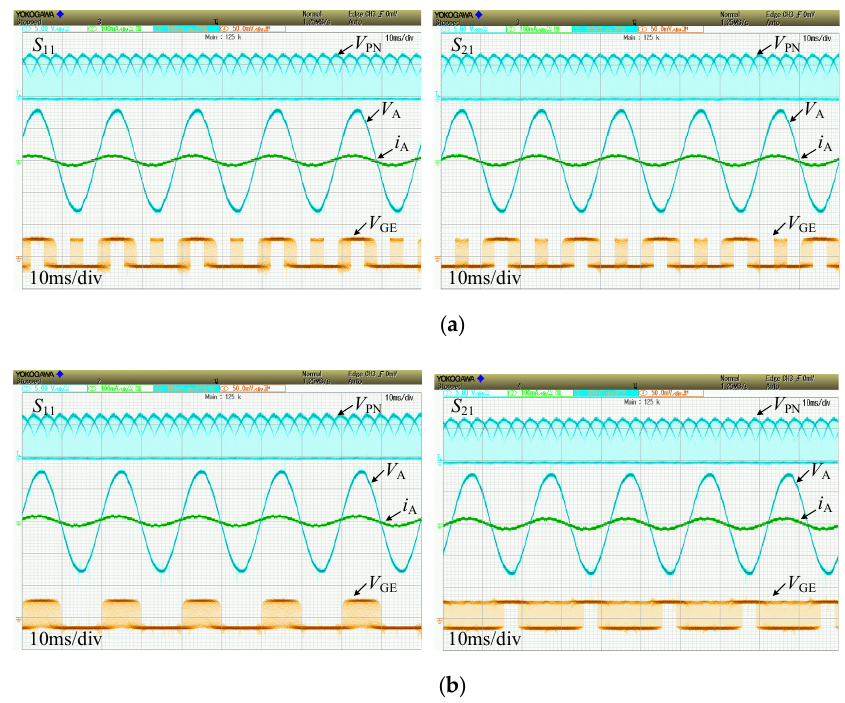
Figure 12. Comparative experimental waveforms: input phase voltage V A (50 V/div), input phase current i A (10 A/div), output voltage V PN (100 V/div), and measured drive signals V GE (10 V/div). ( a ) Conventional standard six-switch CSR. ( b ) Proposed CSR.